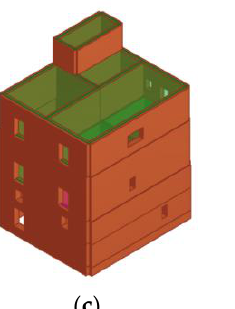
Figure 9. A numerical model of the isolated S.U. located in the intermediate ( a,b ) and head ( c,d ) positions.